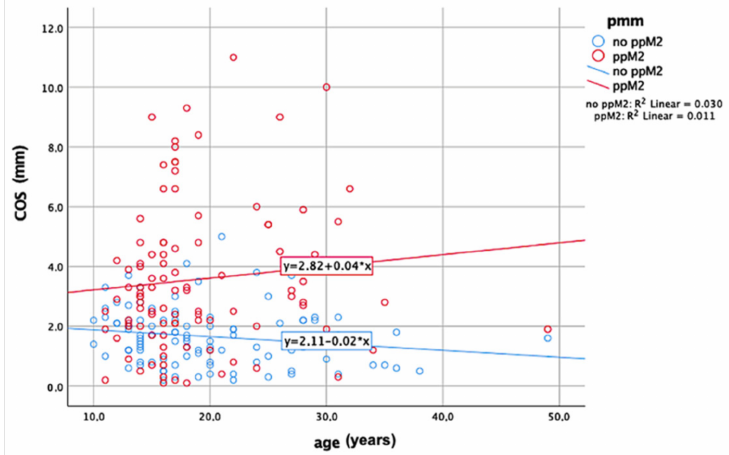
Figure 4. COS depth depending on age.